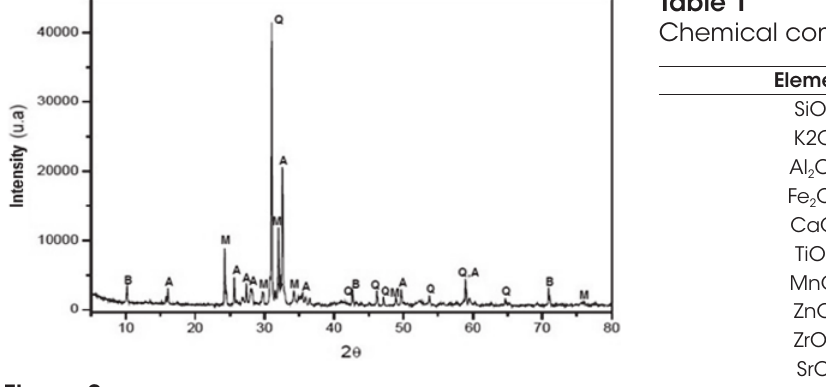
X-ray diffractogram obtained for the ORW